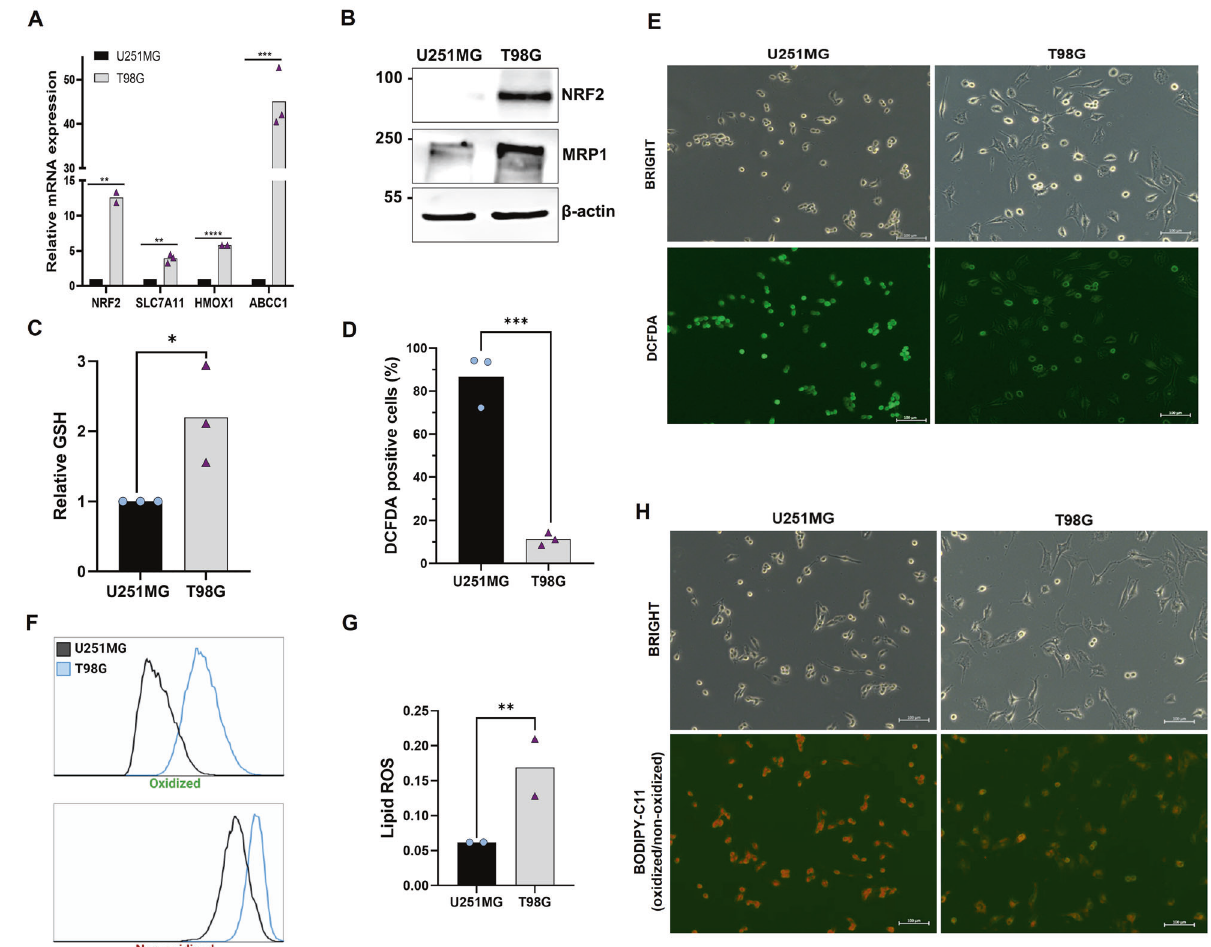
Fig. 2 NRF2 and lipoperoxidation levels in glioblastoma. A Quantitative real-time PCR analysis of NRF2, SLC7A11, HMOX1, and ABCC1 mRNA levels in glioblastoma cells. B Detection of NRF2 and MRP1 protein by western blot in U251MG and T98G cell lines. C Quanti fi cation of basal intracellular GSH in both glioblastoma cells. D Basal level of ROS detected by DCFDA probe and analyzed by fl ow cytometry. E Fluorescence microscopy representative images of basal DCFDA fl uorescence in U251MG and T98G. Scale bar: 100 μ m. F Representative histograms of lipid peroxidation in U251MG and T98G. Cellular stress was induced by RSL3 (1 μ M) treatment and lipid peroxidation was measured by BODIPY-C11 581/591 probe by fl ow cytometry ( G ) and the ratio of oxidized/non-oxidized cells was calculated. H Fluorescence microscopy representative images of basal BODIPY-C11 fl uorescence in U251MG and T98G. Scale bar: 100 μ m. Values are mean ± SEM of two or three independent experiments, ns = not statistically signi fi cant, * P < 0.05, ** P < 0.01, *** P < 0.001, **** P < 0.0001. Each dot represents an independent